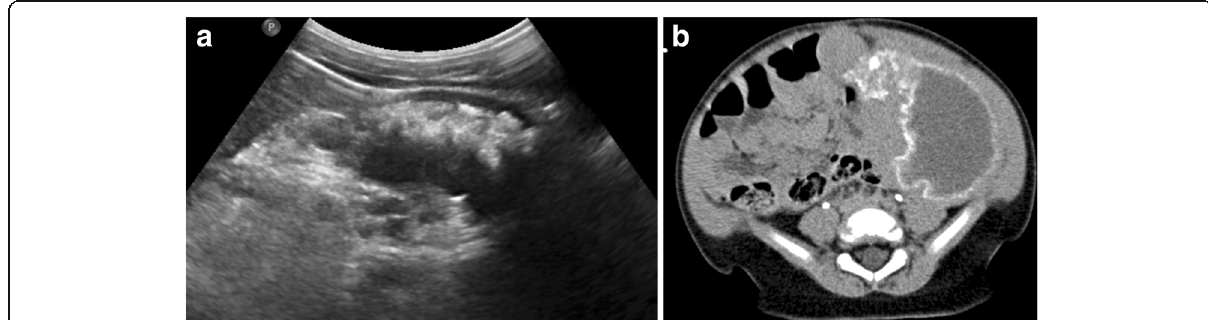
Fig. 5 Splenic necrosis in pediatric Gaucher disease. Transverse grayscale abdominal ultrasound ( a ) of a 2-year-old male Gaucher disease patient with marked splenomegaly shows replacement of normal splenic parenchyma with fluid and hyperechoic regions corresponding to dystrophic calcification. Contrast-enhanced abdominal CT ( b ) of this patient demonstrates enlarged spleen replaced with liquefying necrosis and peripheral